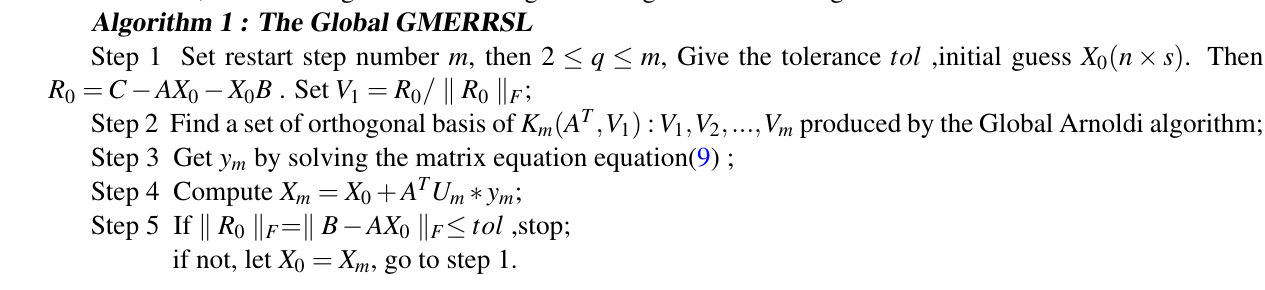
Algorithm 1 : The Global